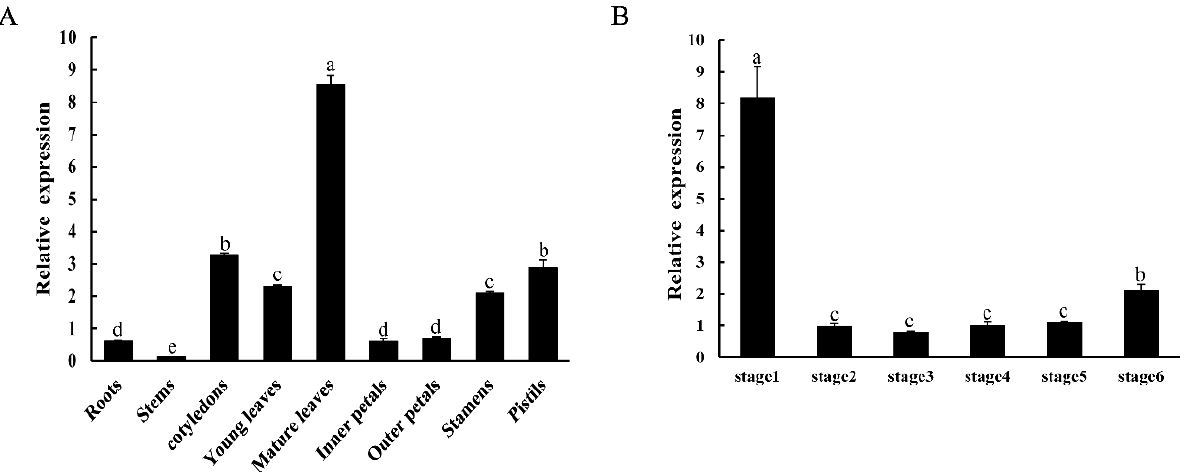
Figure 3. Expression patterns of CpNAC1 in wintersweet. ( A ) Expressions of CpNAC1 in different tissues, including roots, stems, cotyledons, young leaves, mature leaves, inner petals, outer petals, stamen, and pistils. ( B ) Expressions of CpNAC1 in different flower development stages (stages 1–6): stage 1, sprout period; stage 2, flower-bud period; stage 3, display-petal period; stage 4, bloom- initiation period; stage 5, bloom period; stage 6, wither period (Sui et al., 2012). CpActin and CpTublin were used as internal controls. Data represent means of three biological repeats ± standard deviations (SDs). Different lowercase letters indicate significant differences ( p < 0.05).